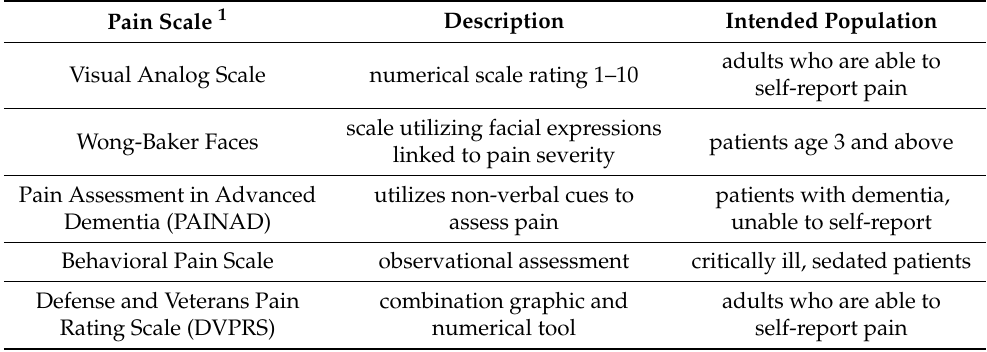
Table 2. Select Available Pain